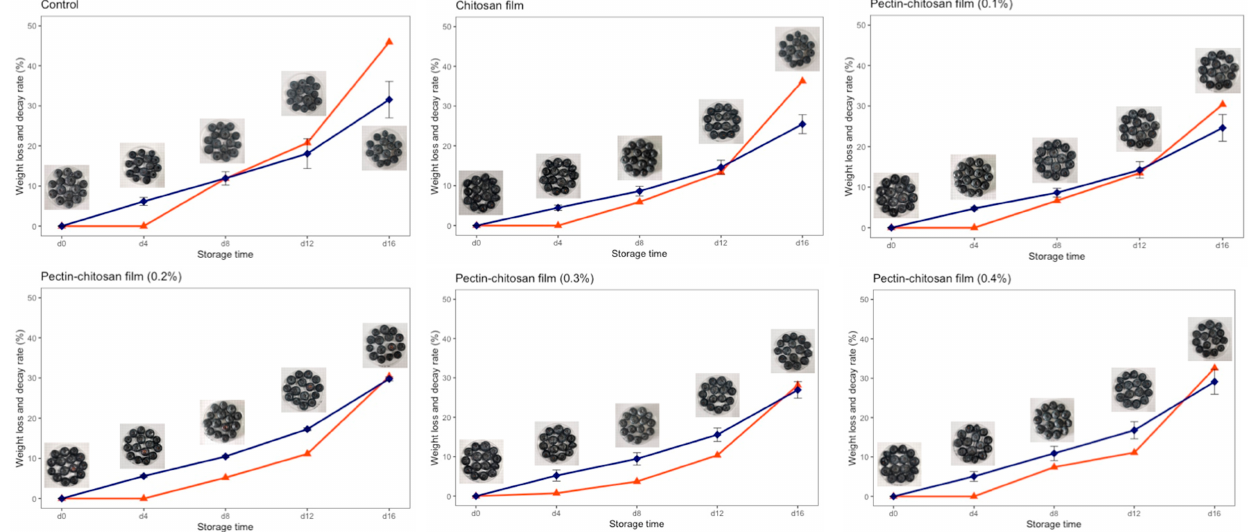
Figure 5. Weight loss and decay rates of blueberry under different treatments. Control represents the untreated